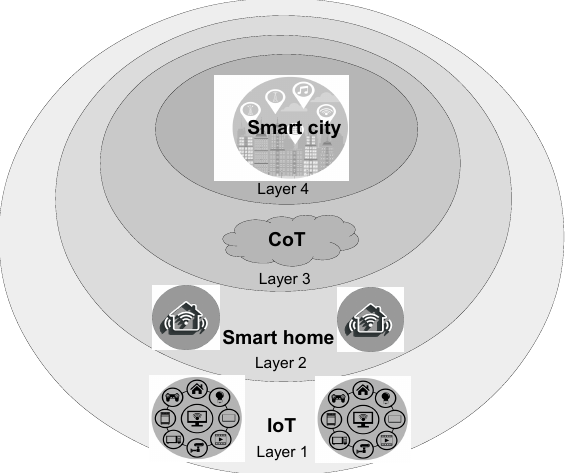
Figure 1. Information and Communications Technology ICT based infrastructure for future smart cities illustrated as a hierarchical model.